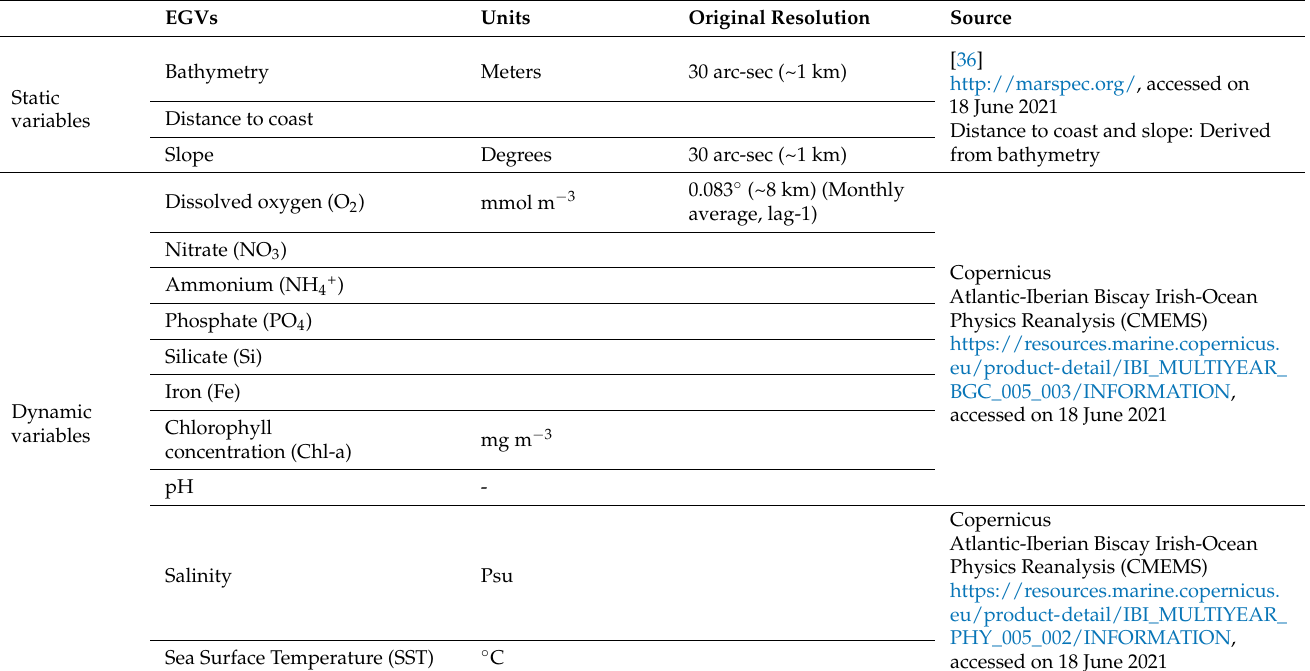
Table 1. Eco-geographical variables (EGVs, units, resolution, and source) extracted from online repositories and incorporated in the preliminary